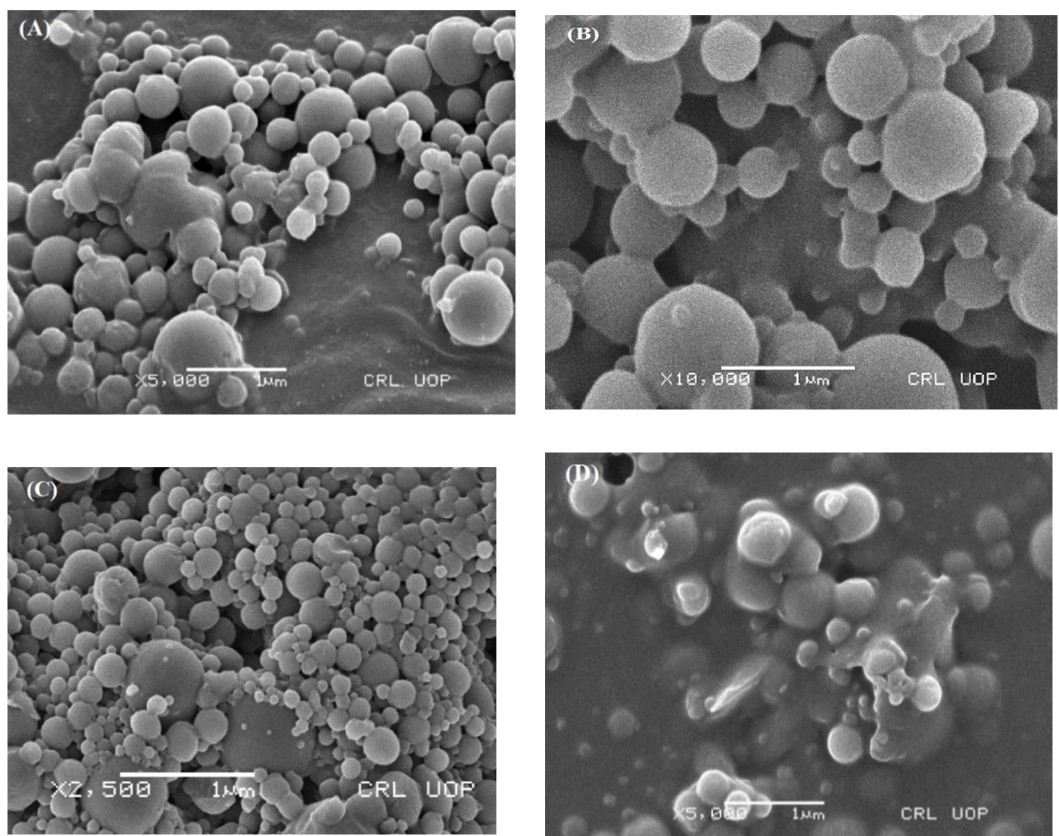
Figure 5. Scanning electron microscope (SEM) images of the optimized ACR-PCL-NPs. ( A ) 5000 × magnification, ( B ) 10,000 × magnification, ( C ) 2500 × magnification), and ( D ) 5000 × magnification.